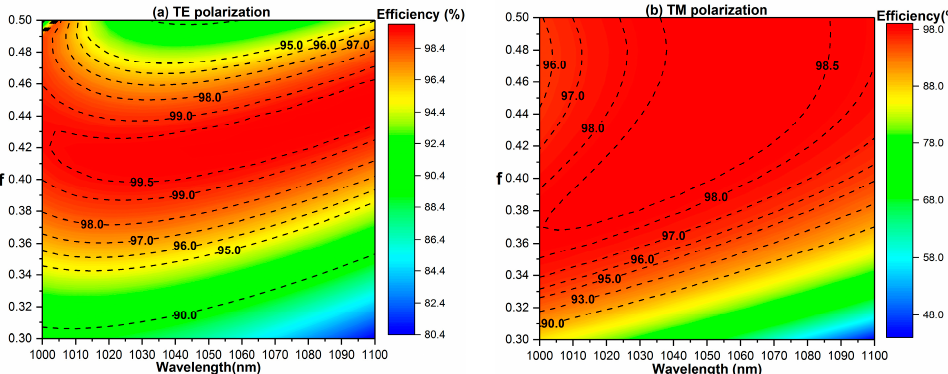
Figure 5. Tolerance analysis of duty cycle. − 1st order diffraction efficiency versus incident wavelength and for ( a ) TE and ( b ) TM polarizations.